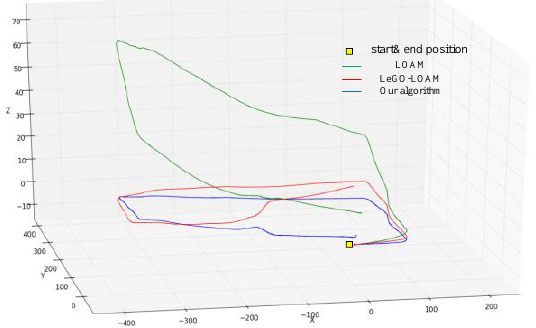
Figure 8. Trajectory of Site 1 for three